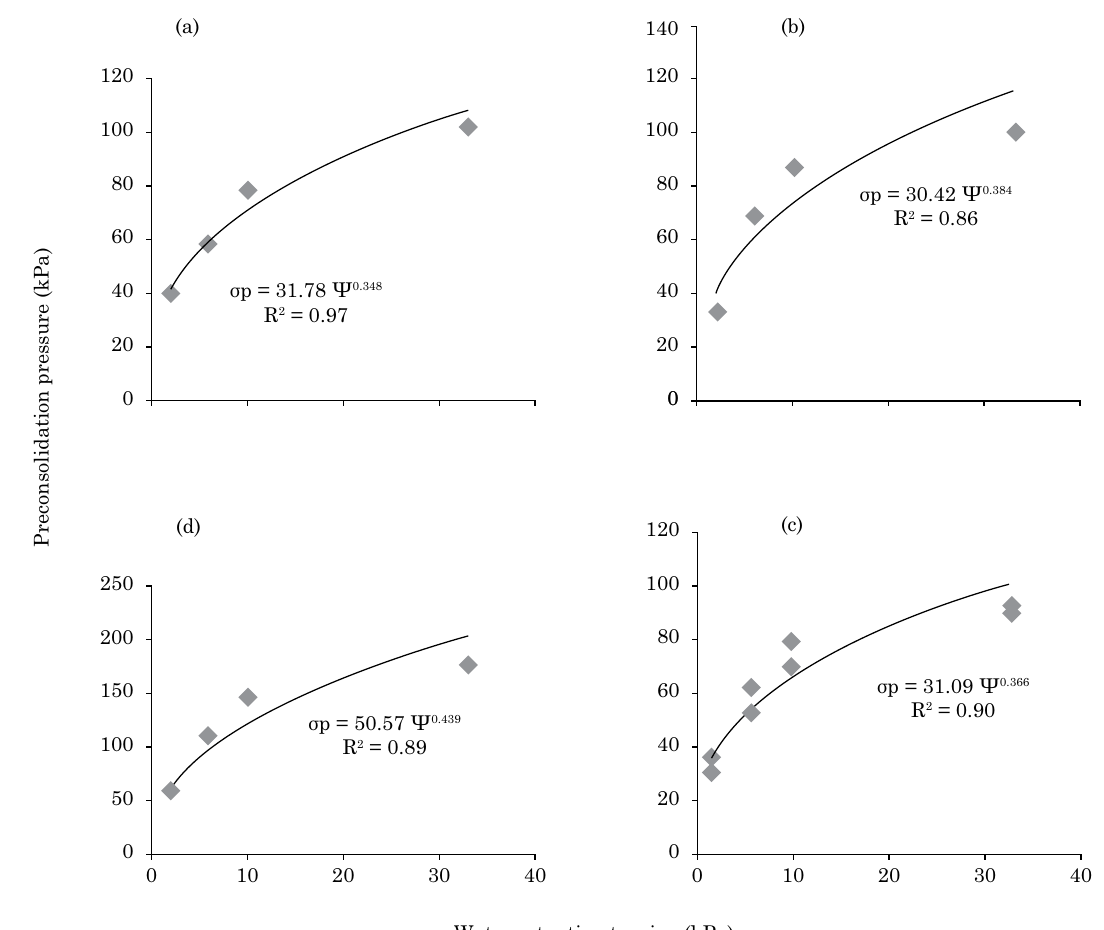
Figure 2. Preconsolidation pressure modeling (σp) in Latossolo Vermelho-Amarelo distrófico (Oxisol) under no-tillage system (a), natural forest (b), sheep grazing (c) and natural forest and no-tillage system (d) at varied water retention